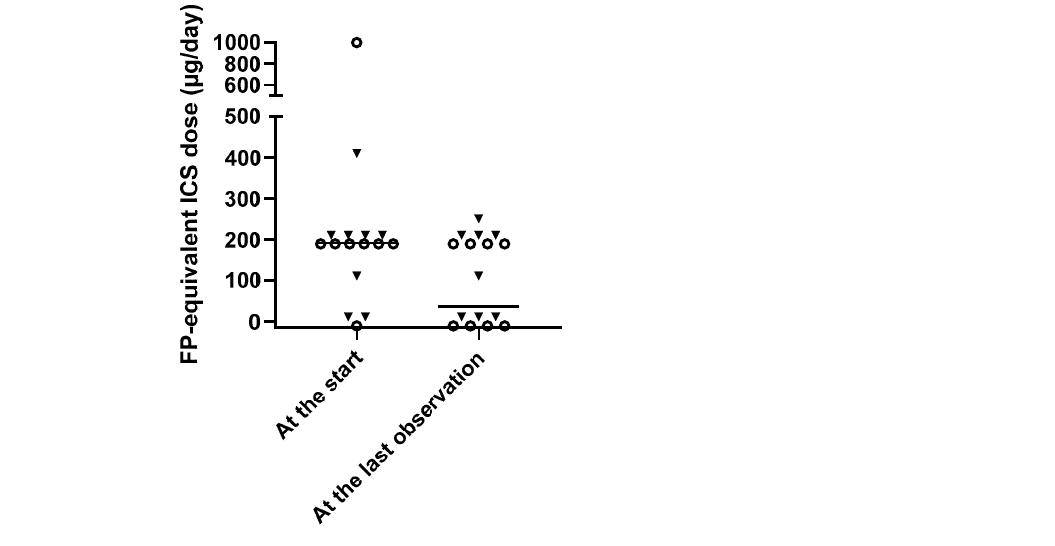
Figure 3. Fluticasone propionate (FP)-equivalent ICS doses at the start and at the last observation of HDM-SCIT (at the last visit of each patient in the study period). Open circles indicate subjects in Group I, while closed squares indicate subjects in Group D. In all subjects, the difference between the doses at the 2 time points was statistically significant. p < 0.05, Mann–Whitney U test.